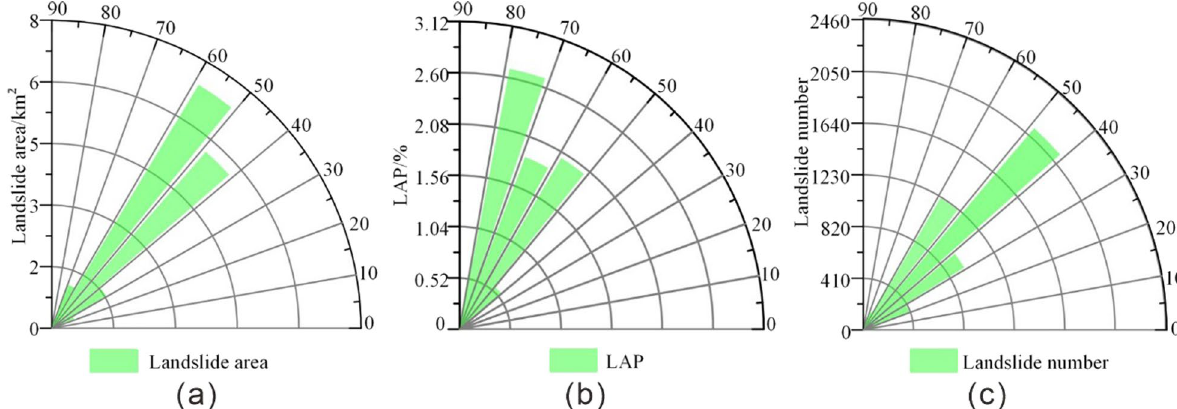
Fig. 9 Analysis diagram for landslide evaluation index and